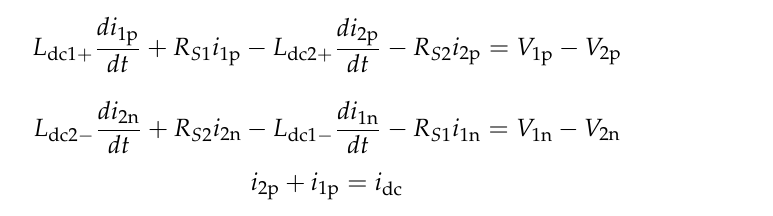
We write the loop equation and node voltage equation according to the DC equivalent circuit shown in Figure 4.